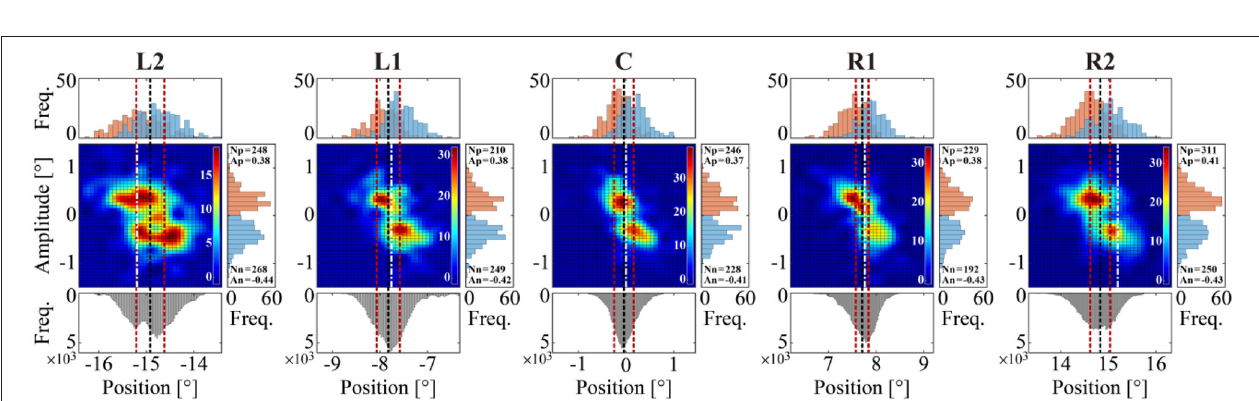
FIGURE 6 | Relationships between the onset position of MS and its amplitude for each of the five target positions. Color map: two-dimensional histograms of the onset position and amplitude of MS with 0.25 ◦ and 0.20 ◦ bin widths, respectively, representing the joint frequency of onset positions and amplitudes of MS events. Upper histograms: one-dimensional histograms with a bin width of 0.10 ◦ for each of the rightward (red) and leftward (blue) MS events. Right-side histograms: one-dimensional histograms with a bin width of 0.10 ◦ for each of the rightward (red) and leftward (blue) MS events. In the right-side histograms, N p and N n are the rightward and leftward MS counts, respectively. Similarly, A p and A n are the mean amplitude of rightward and leftward MS. For each target condition, the black dotted line represents the mean value of the GZ time series, and the red dotted lines on both sides of the black line represent ± SD away from the mean value of the GZ time series. The dashed white line represents the fixation target position in each target condition.